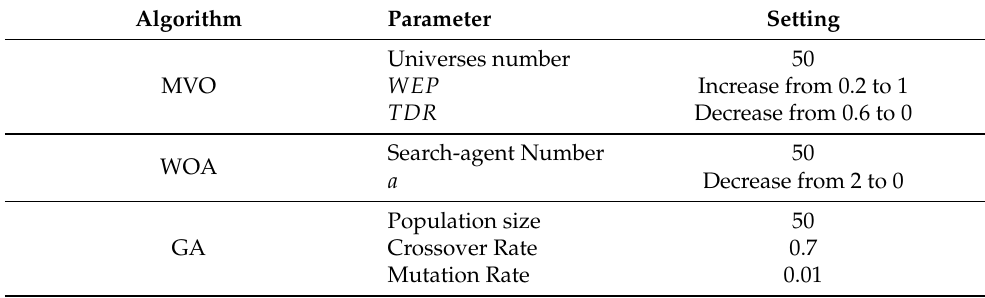
Table 3. The parameters of